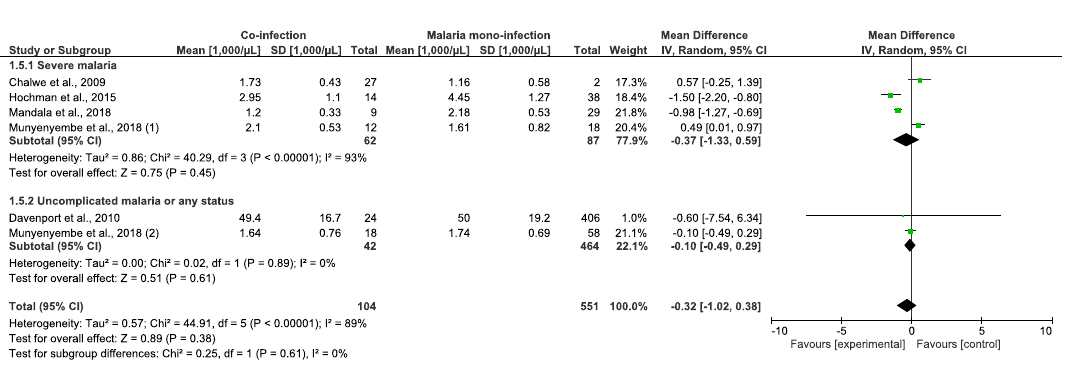
Figure 7. The pooled MD of lymphocyte counts between Plasmodium spp. and HIV co-infected and Plasmodium spp.